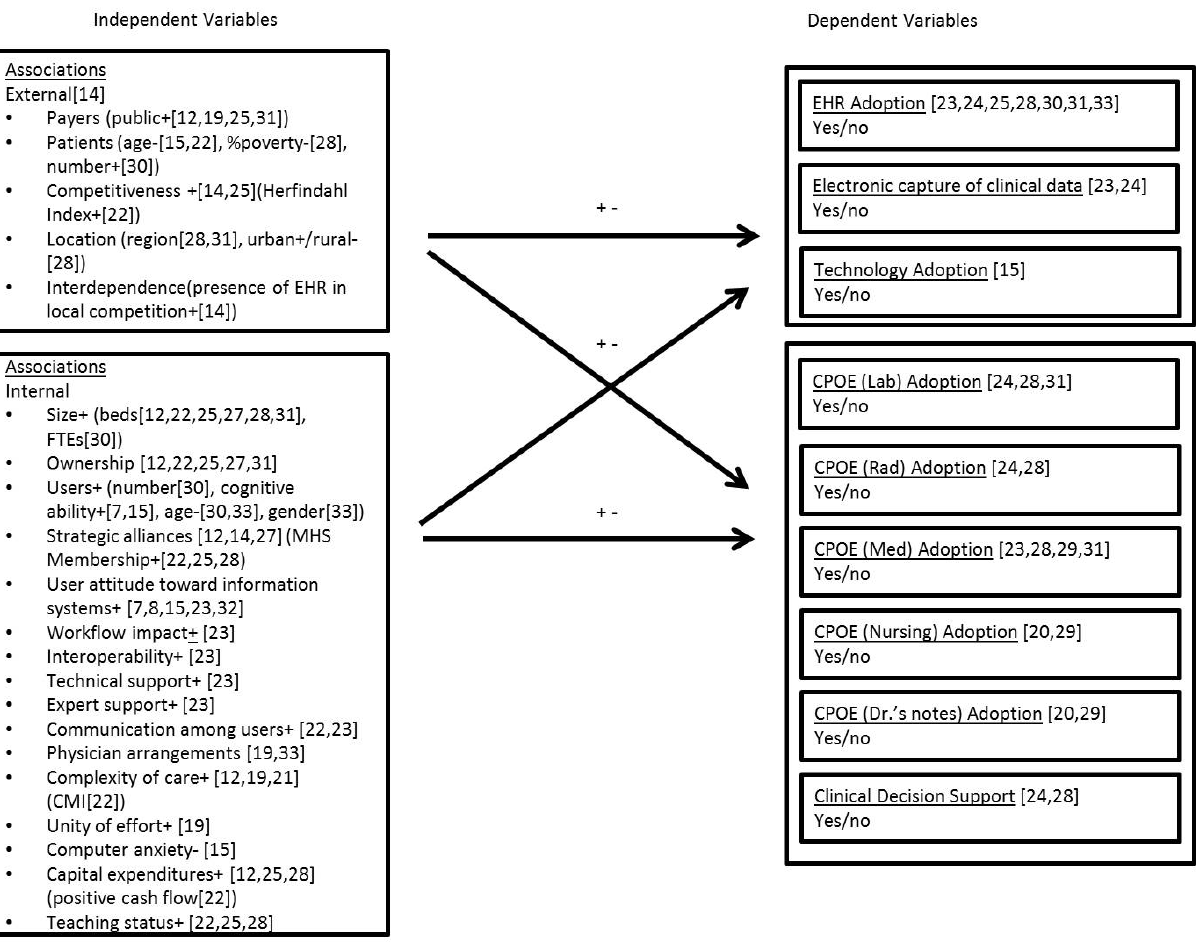
Figure 2. Conceptual model of factors associated with adoption of the